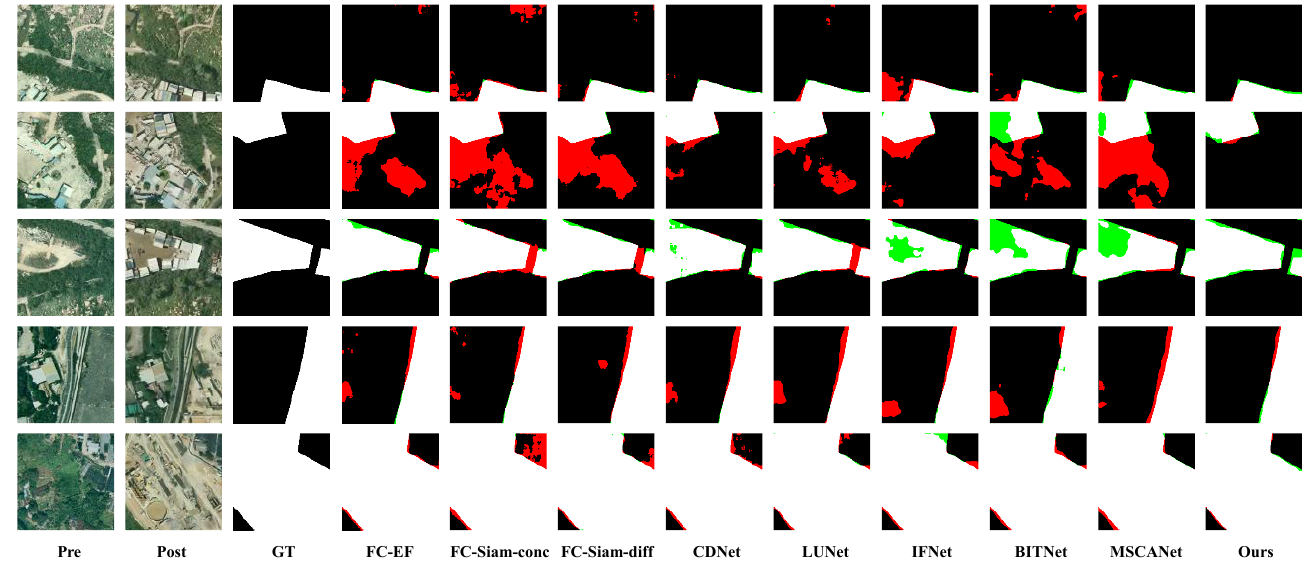
Figure 8. Visualization results of different CD methods in five scenarios from the SYSU-CD dataset. We plot the FP in red and the FN in green in order to better compare the CD results.